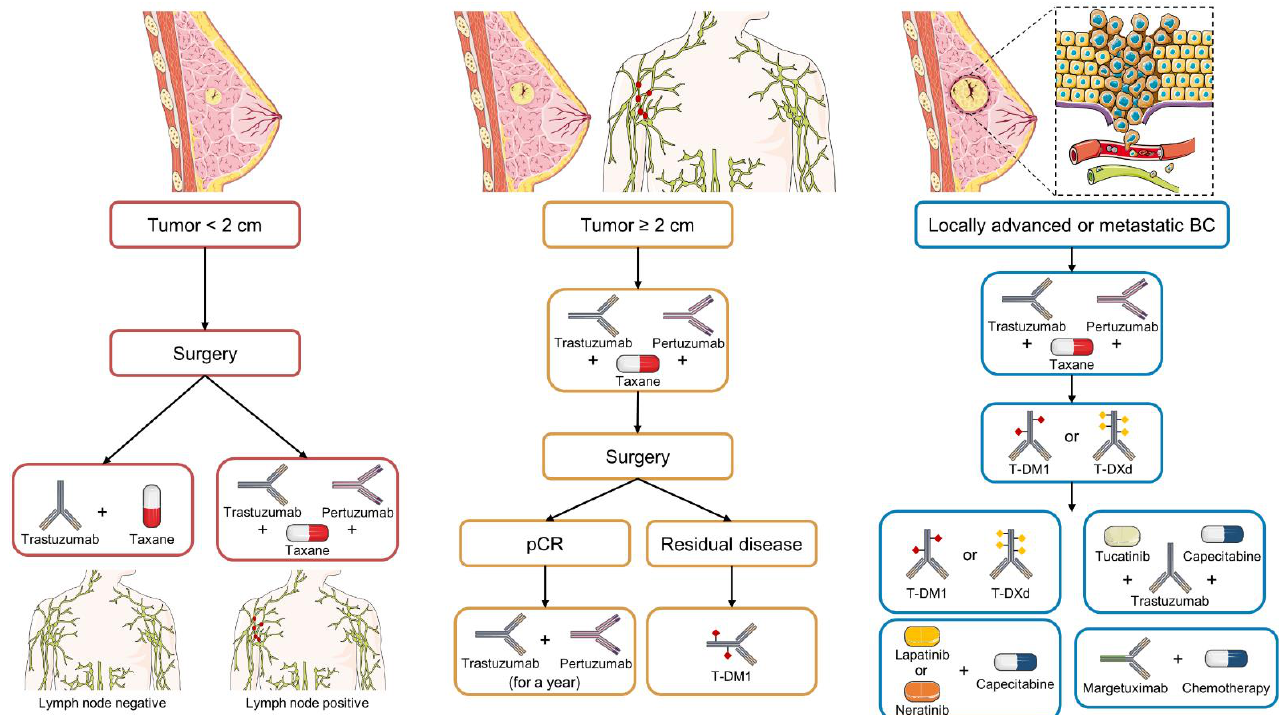
Figure 1. Current established treatment protocol for early-stage, advanced, or metastatic HER2 BC according to ASCO and NCCN guidelines. The different treatment options for each stage are presented sequentially based on their strength of recommendation. Icons designed with smart.servier.com and Adobe Illustrator.